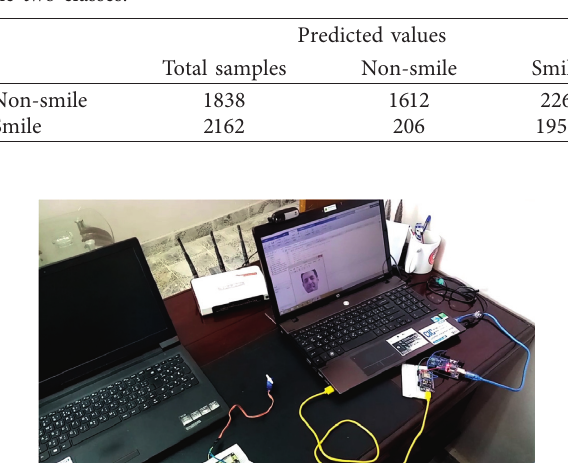
Table 5: Confusion matrix of the whole dataset recognition rate of the two classes.